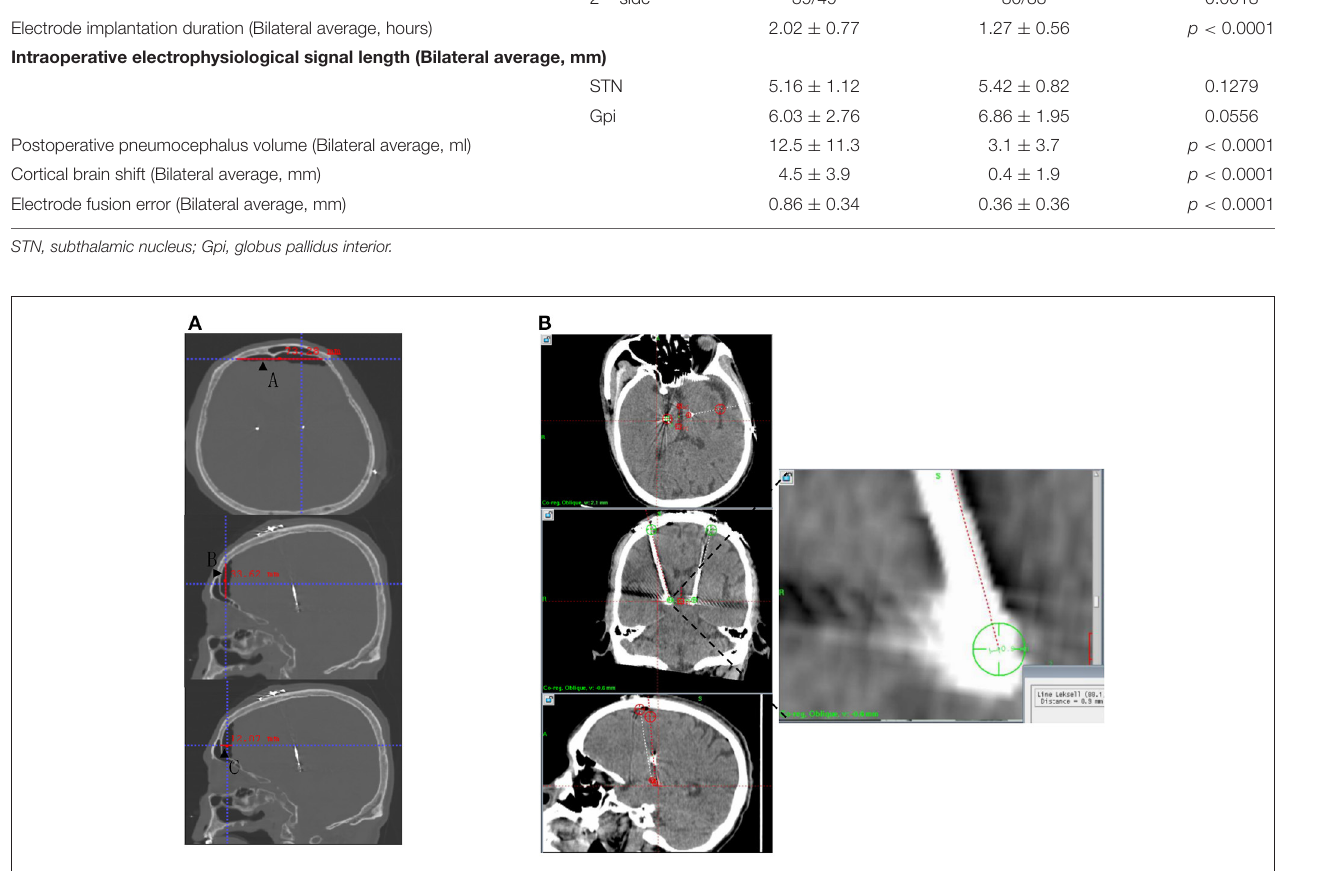
FIGURE 2 | Postoperative CT data measurement. (A) PPV and CBS were calculated from A, B, and C under the same coordinate system measured after postoperative CT postprocessing. (B) Postoperative CT was fused with preoperative planning to measure EFE. CBS, Cortical brain shift; CT, computed tomography; EFE, Electrode fusion error; PPV, Postoperative pneumocephalus